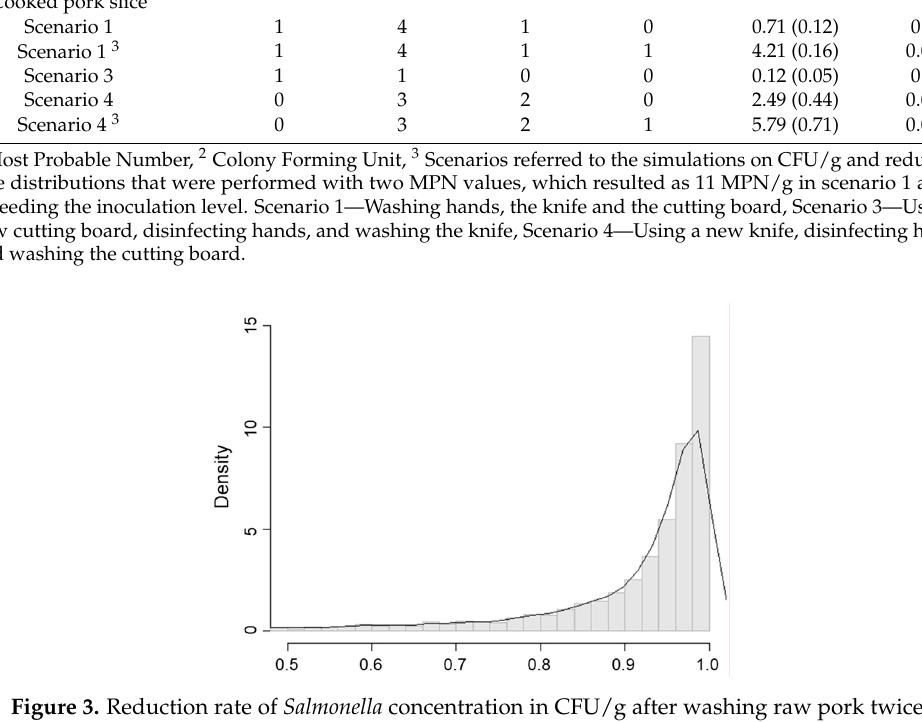
Figure 3. Reduction rate of Salmonella concentration in CFU/g after washing raw pork twice.